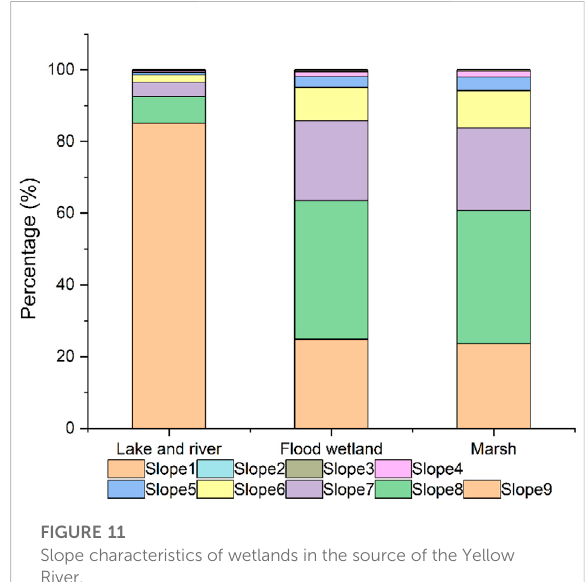
3D wetland map of the Yellow River Source.